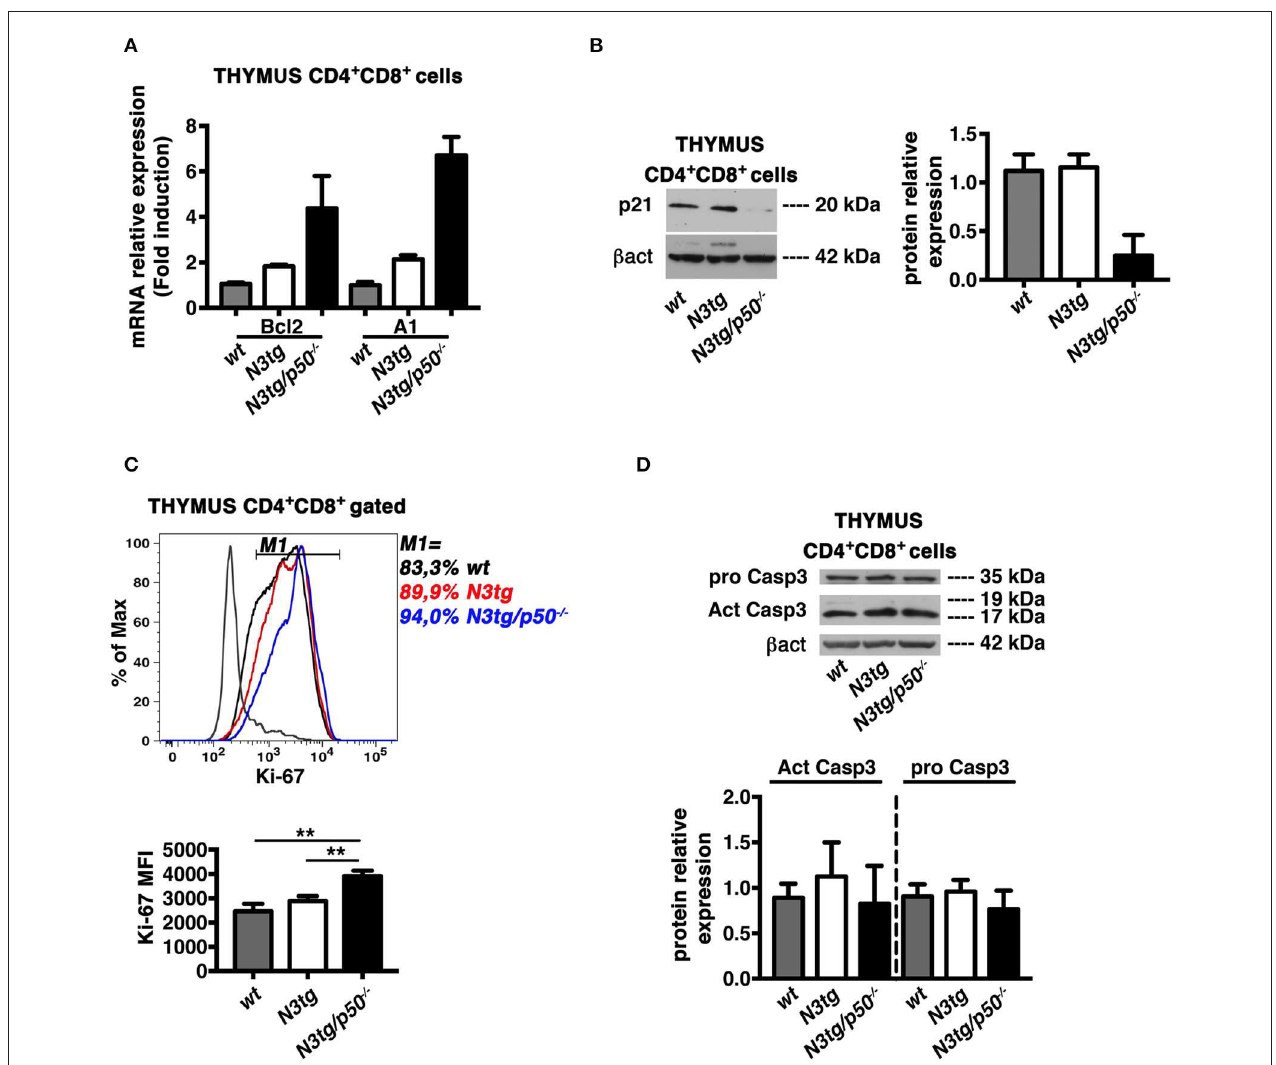
FIGURE 12 | NF- κ B1 deletion increases CD4 + CD8 + (DP) T cell apoptosis in N3tg/p50 − / − vs. N3tg mice, through a p21 Waf1 / Cip1 -dependent mechanism. (A) Relative mRNA expression levels of Bcl-2 and A1 evaluated by real-time RT-PCR in DP T cells isolated from thymus of N3tg/p50 − / − , N3tg , or wt mice at 4–5 weeks of age. The expression levels of Bcl-2 or A1 in wt DP thymocytes were set as 1. Mean values ± SD are shown and they were obtained from two independent experiments ( n = 2 mice per group), each in triplicate. (B) In the left panel , representative Western blot analysis of p21 Waf1 / Cip1 protein expression levels in whole-cell extracts of DP T cells isolated from thymus of N3tg/p50 − / − , N3tg , or wt mice at 4–5 weeks of age. Anti β -actin ( β -act) antibody was used as loading control. In the right panel , the densitometric analysis of protein expression levels are shown. The values are presented as mean ± SD of two independent experiments ( n = 2 mice per group). The p21 Waf1 / Cip1 protein expression levels in wt DP thymocytes were set as 1. (C) In the upper panel , histogram of Ki-67 expression inside gated CD4 + CD8 + (DP) T cells from thymus of N3tg/p50 − / − (blue line), N3tg (red line), and wt (black line) mice at 4–5 weeks of age, assessed by flow cytometry. The staining negative control is also shown (gray line). M1 gate defines the percentages of Ki-67 + cells. Data are representative of three independent experiments. In the lower panel , the graph illustrates the MFI of the Ki-67 marker inside CD4 + CD8 + (DP) thymocytes in the same samples as in the upper panel . The values are presented as mean ± SD of three independent experiments ( n = 3 mice per group). ** P ≤ 0.01 represent significant differences between the indicated groups. (D) In the upper panel , representative Western blot analysis of pro-caspase-3 and active caspase-3 protein expression levels in whole-cell extracts of DP T cells isolated from thymus of N3tg/p50 − / − , N3tg , or wt mice at 4–5 weeks of age. Anti β -actin ( β act) antibody was used as loading control. In the lower panel , the densitometric analysis of protein expression levels of active caspase-3 and pro-caspase-3 protein are shown. The values are presented as mean ± SD of two independent experiments ( n = 2 mice per group). In the graphs the protein expression levels in wt DP thymocytes were set as